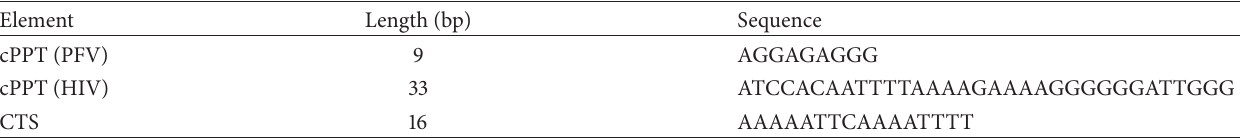
Table 1: Sequences of the viral structural elements used in the construction of modified expression vectors. Element